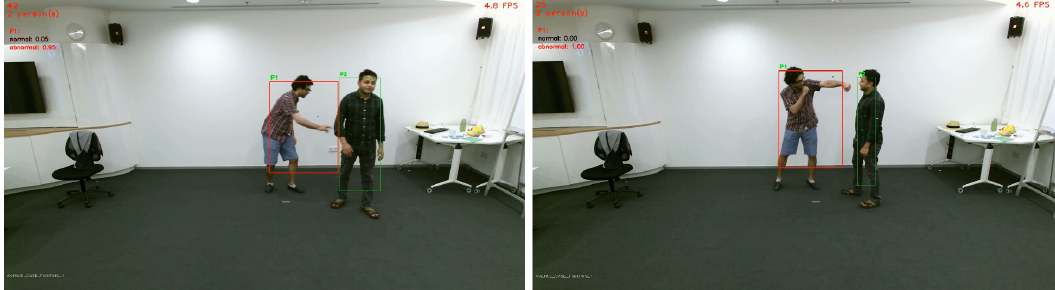
Figure 21. Additional evaluation on the NTU-RGB dataset. Metrics at the top-left depict the prediction scores for the P1.